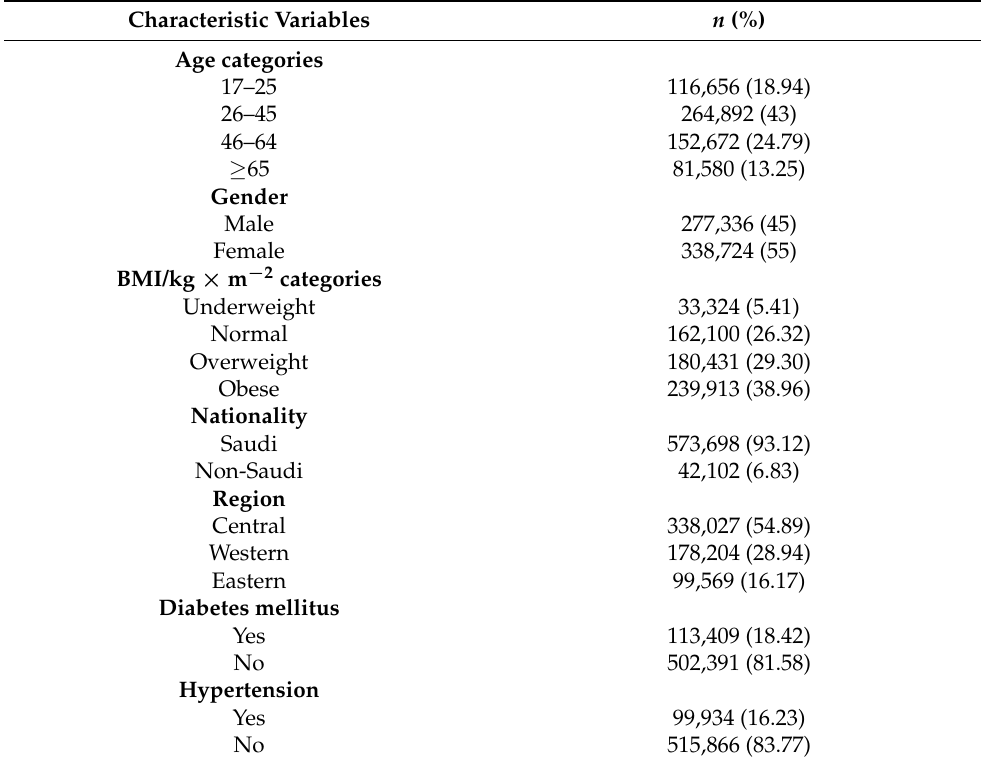
Table 1. Baseline characteristics of the patients treated in National Guard Hospitals from five regions ( n =